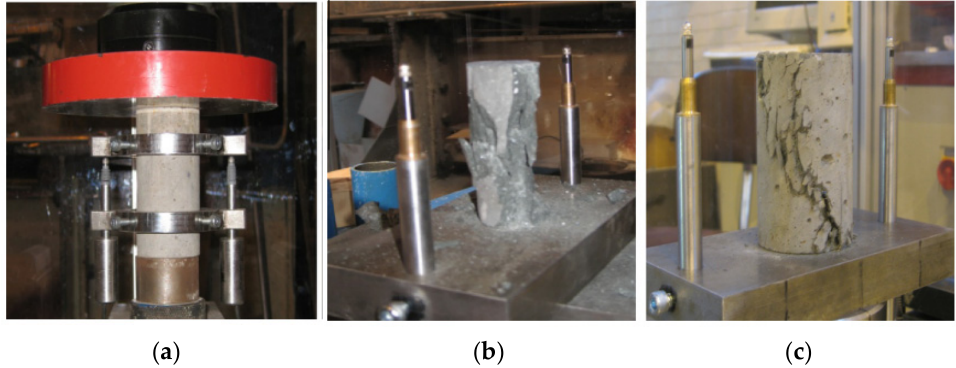
Figure 3. Evaluation of the compressive strength of UHPFRC. ( a ) Uniaxial compression test set up and ( b , c ) formation of cracks and UHPFRC failure ([30]–Elsevier Copyright).